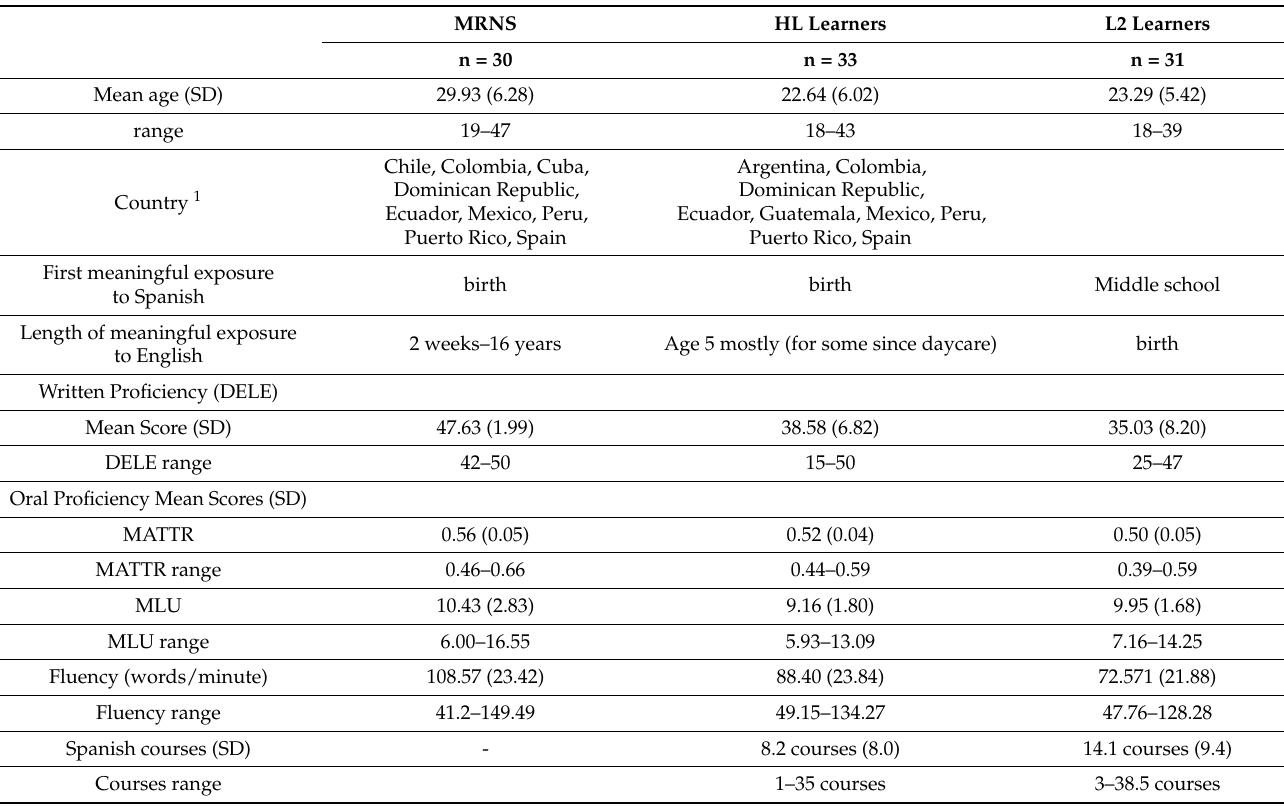
Table 1. Participants’